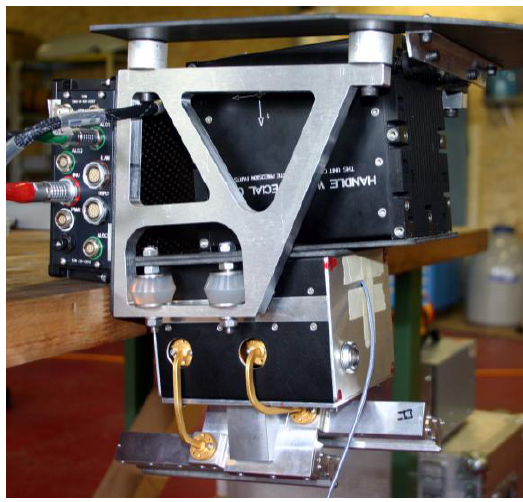
Fig. 10 Compact sensor package consisting of SAR-frontend with antennas, IMU and navigation computer